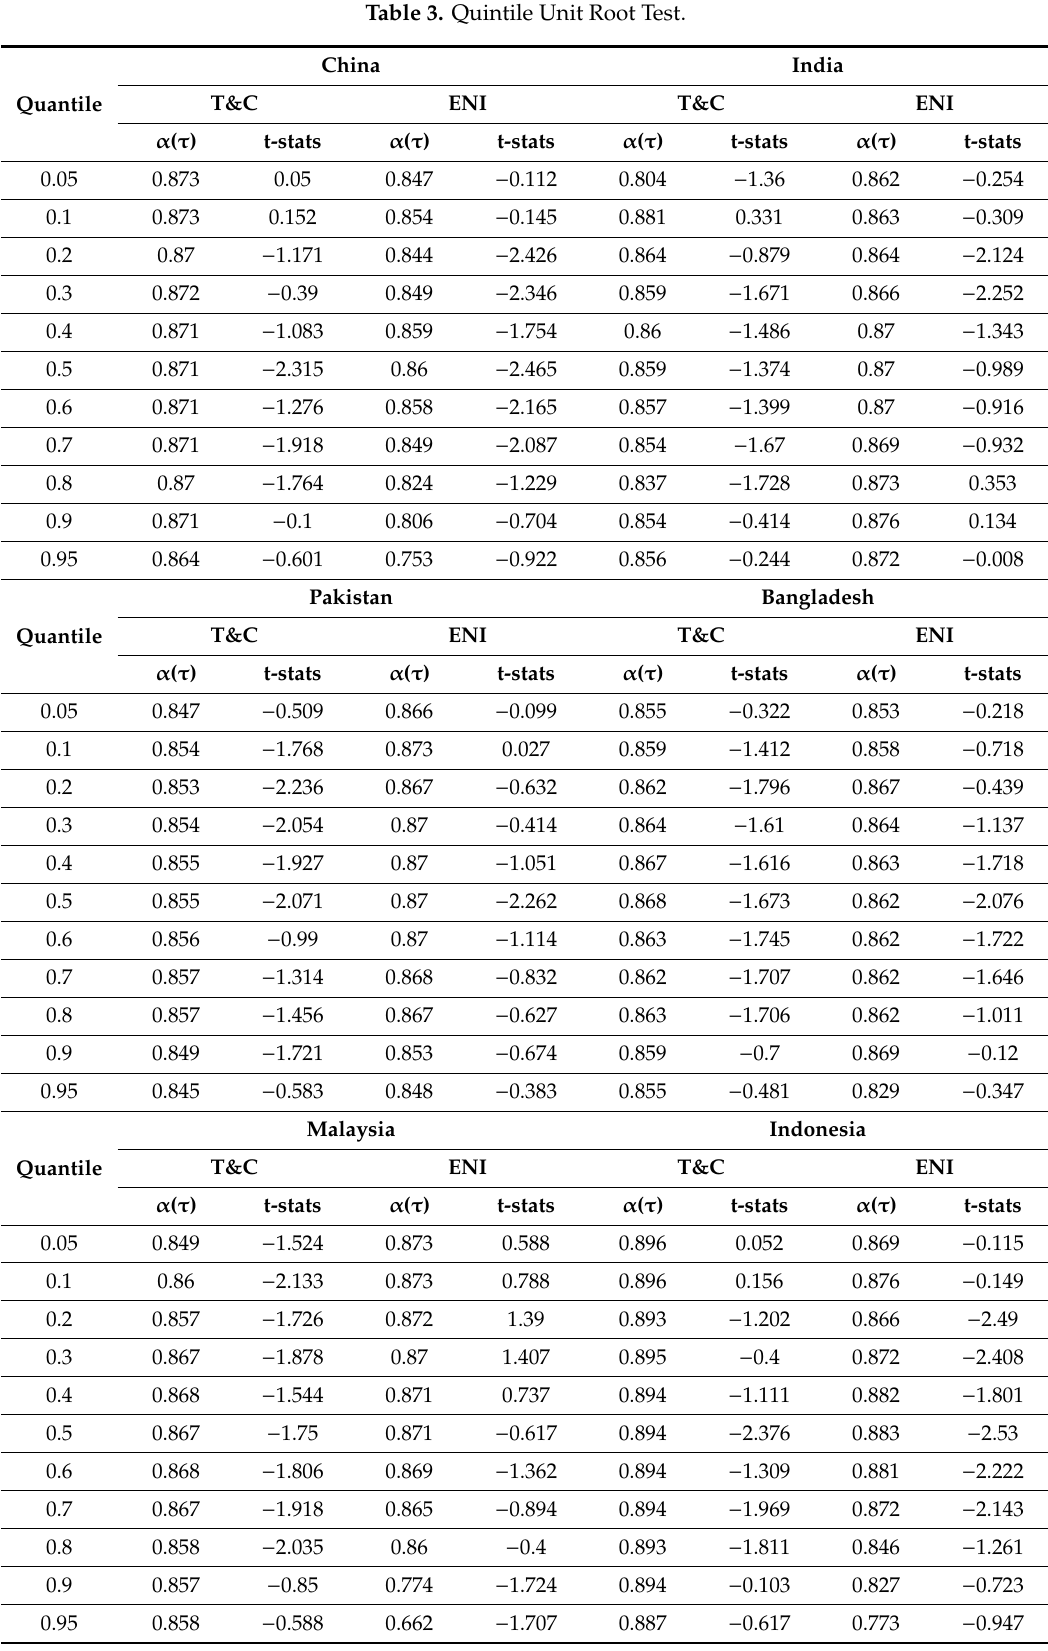
Table 3. Quintile Unit Root